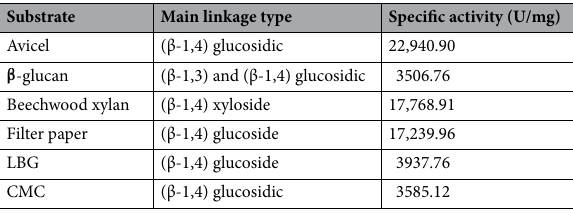
Table 1. Specific activity of the PersiXyn8 on various